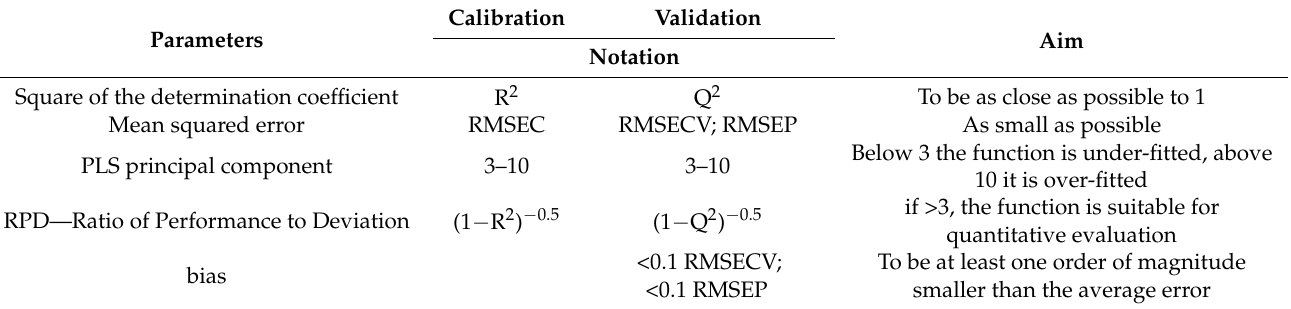
Table 2. Characteristic qualifying parameters of PLS